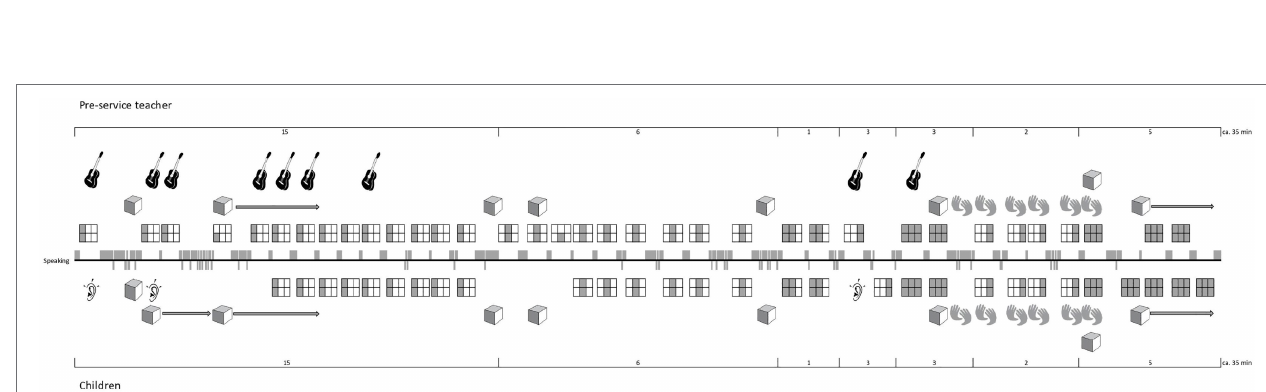
FIGURE 6 | An example of a Lesson Activities Map (LAMap). It is the transcript—based on video recordings—of the recurrent activities that constitute the course of a singing lesson (see key in Figure 5 ). Note the visualization of the song transmission process that starts with the teacher’s presentation of the first verse, and that ends with the children’s own reproduction of all three verses (Case study with Florence, © by Savona,